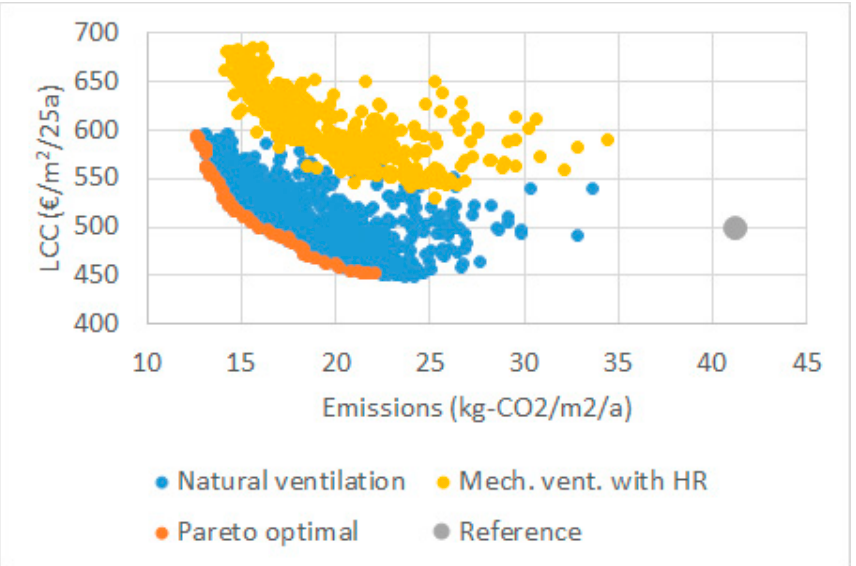
Figure 6. Results from the optimization of SH1 with district heating. Mechanical ventilation cases are shown in a separate cluster due to their higher investment costs. Mechanical supply and exhaust ventilation improve indoor air quality, which is not considered in the optimization.